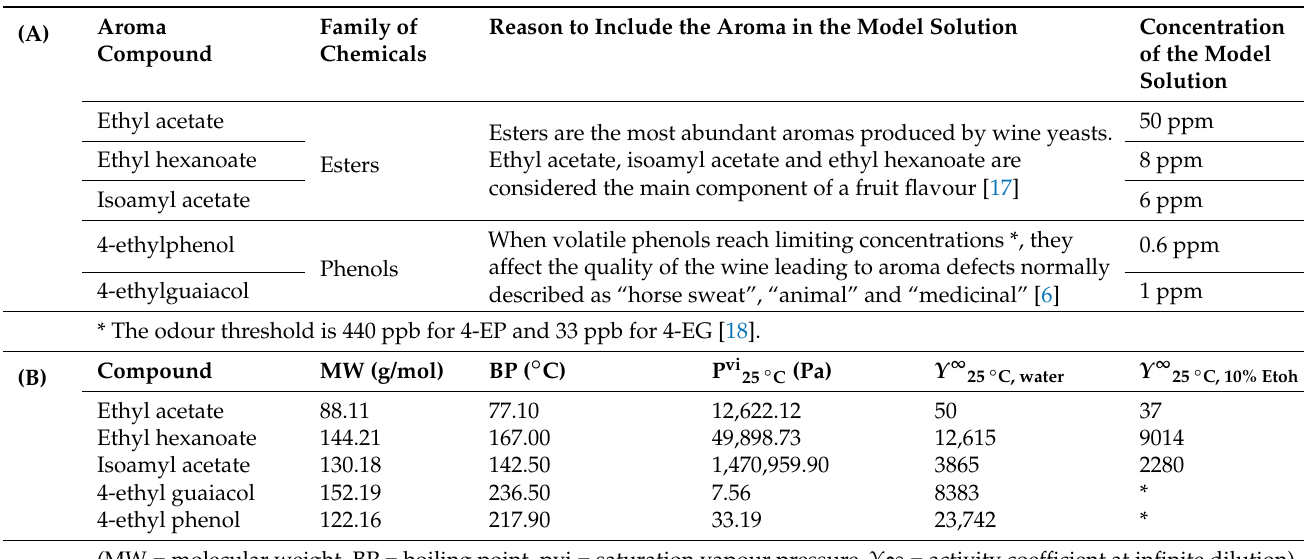
Table 1. Composition of the model solution of red wine: ( A ) characterisation of the selected red wine aroma compounds and ( B ) the physicochemical properties of the aroma